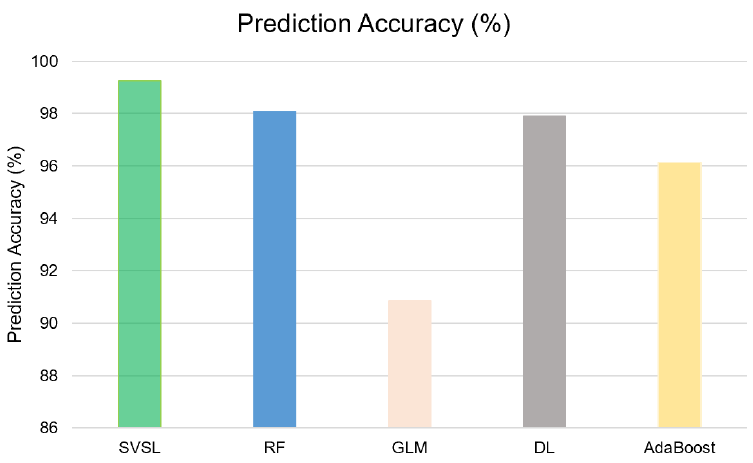
Figure 4. Prediction accuracy (%) of the SVSL method, RF, GLM, DL, and AdaBoost. The normalized confusion matrices of the SVSL method, DL, GLM, RF, and AdaBoost are shown in Figures 5 – 9. Each confusion matrix contains the sum of the rightly classified and misclassified classes. The diagonal of the matrix represents the rightly classified class details.